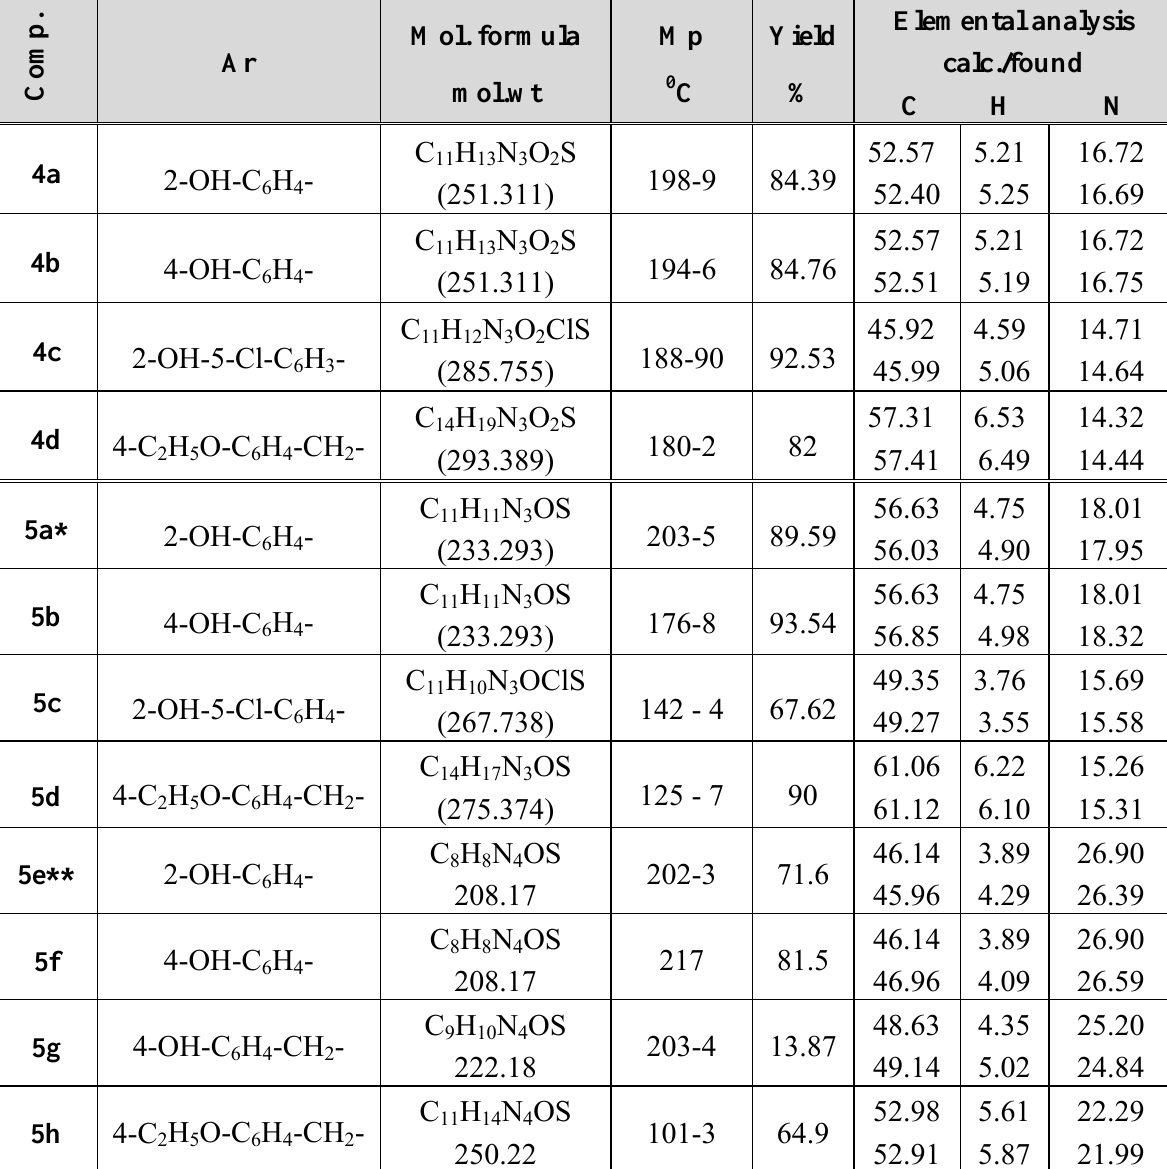
Table 1: Physical and analytical data of compounds 4a-d and 5a-h